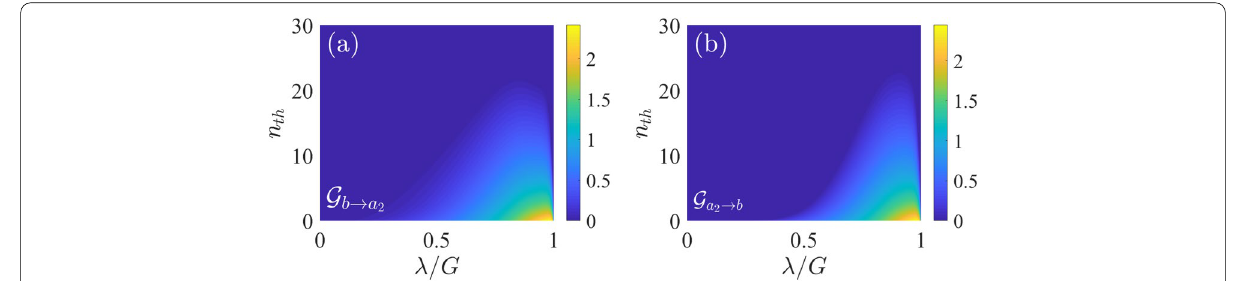
G 2 / (cid:31) , and the 2 ω m , J = =